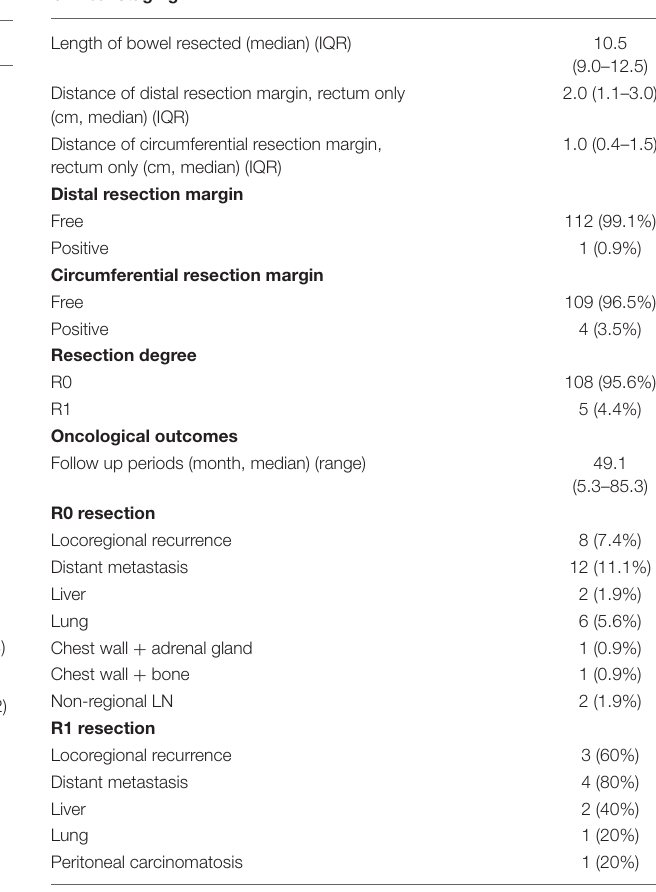
TABLE 3 | Pathological characteristics and oncological outcomes of 113 patients with rectal or sigmoid colon cancer who underwent totally robotic-assisted TME with the high dissection and selective ligation